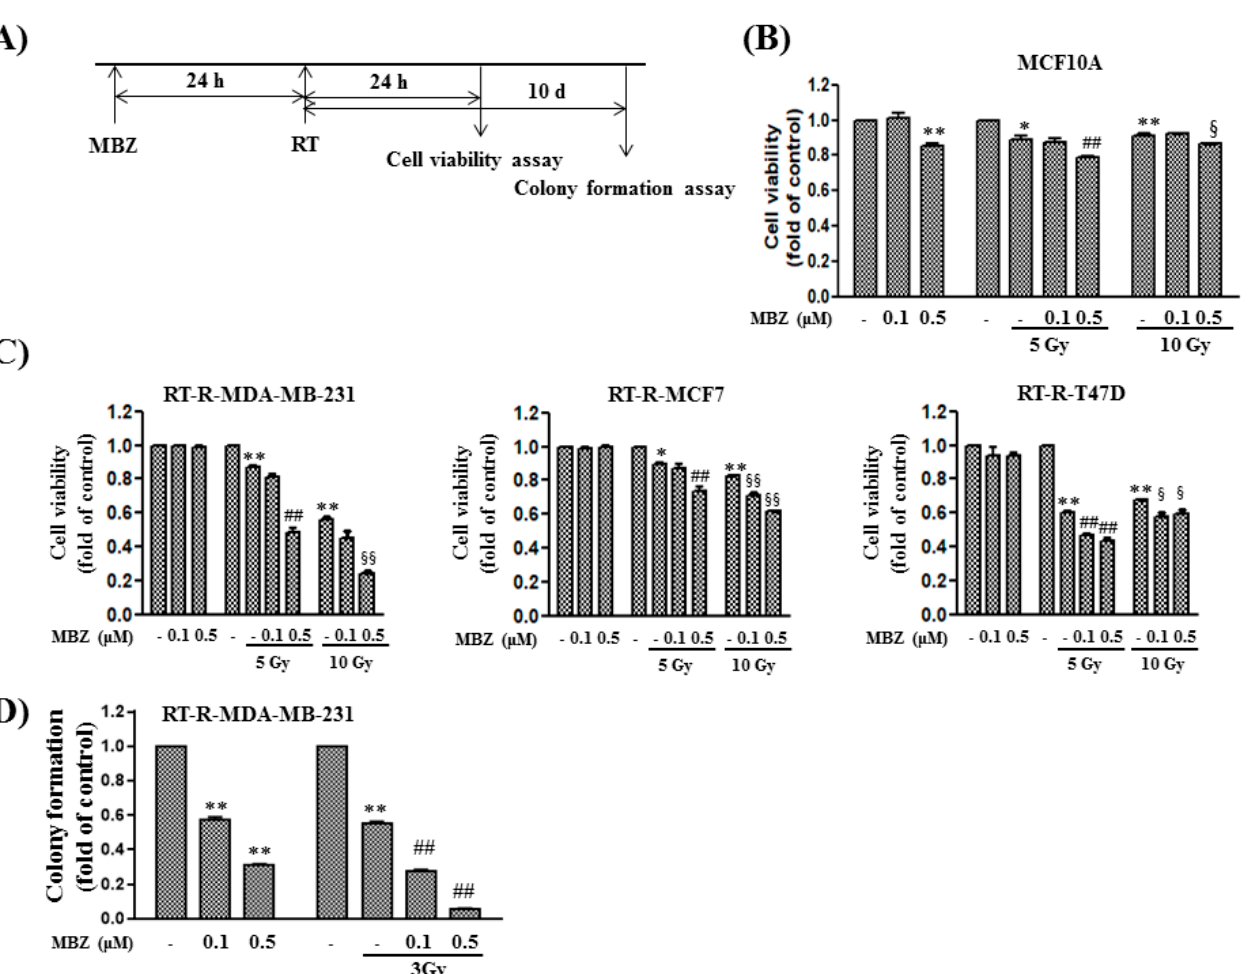
Figure 3. The combination of mebendazole (MBZ) and radiotherapy (RT) effectively reduces cell viability of triple negative breast cancer-derived RT-resistant-MDA-MB-231 (RT-R-MDA-MB-231) cells without causing serious cytotoxicity in normal epithelial MCF-10A cells. ( A ) Experimental scheme. ( B ) Normal breast epithelial cells, MCF10A, and ( C ) RT-resistant (RT-R) breast cancer cells, RT-R-MDA-MB-231, RT-R-MCF-7, and RT-R-T47D were treated with MBZ at the indicated concentrations (0.1, 0.5 μ M) for 24 h and then irradiated with different does of X-rays (5 Gy, 10 Gy). After 24 h, cell viability was measured using the CCK-8 assay kit as described in the Materials and Methods. The data are represented as the mean ± standard deviation (SD) (* p < 0.05, ** p < 0.01 compared with the control; ## p < 0.01 compared with the control of RT 5 Gy; § p < 0.05, §§ p < 0.01 compared with the control of RT 10 Gy). ( D ) RT-R-MDA-MB-231 cells were treated with MBZ at the indicated concentrations (0.1, 0.5 μ M) for 24 h and then irradiated with a 3 Gy dose of X-rays. After 24 h, the cells were seeded in 6-well plates (1 × 10 3 cells/well). The culture medium was replaced with complete medium every 2–3 days. After 10 days, the colonies were fixed, stained with 0.1% Giemsa staining solution, and visible colonies were counted. The data are presented as the mean ± SD (** p < 0.01 compared with the control; ## p < 0.01 compared with the control of RT).